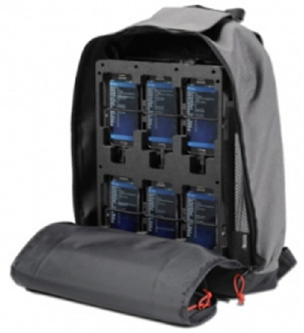
Figure 5. Bag pack with six mounted smartphones.